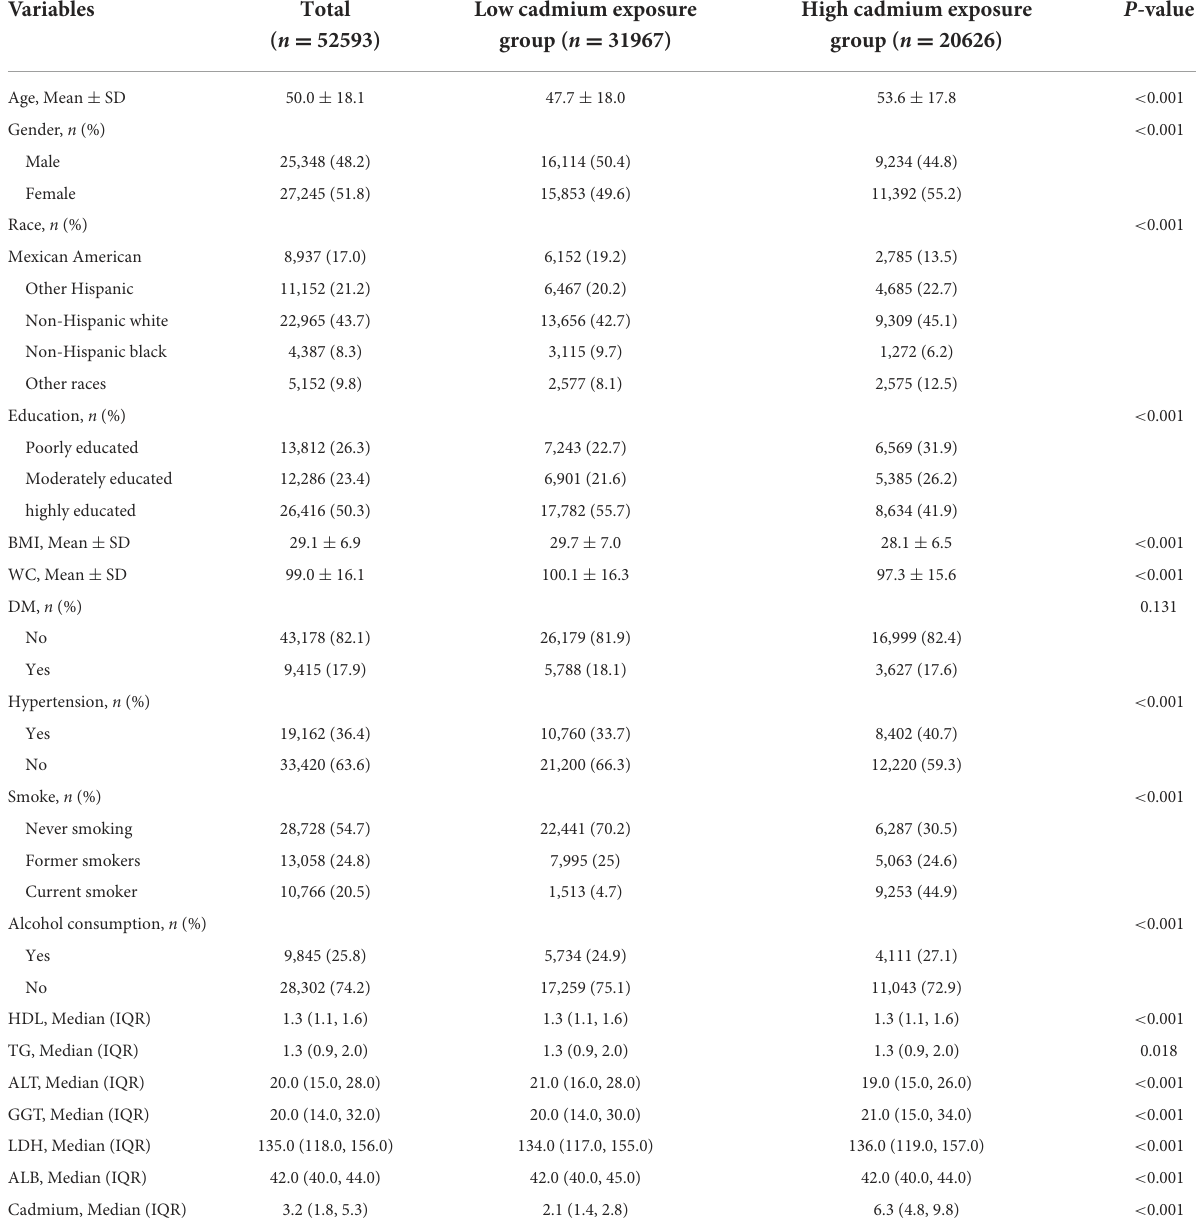
TABLE 1 Characteristics of participants according to serum cadmium exposure